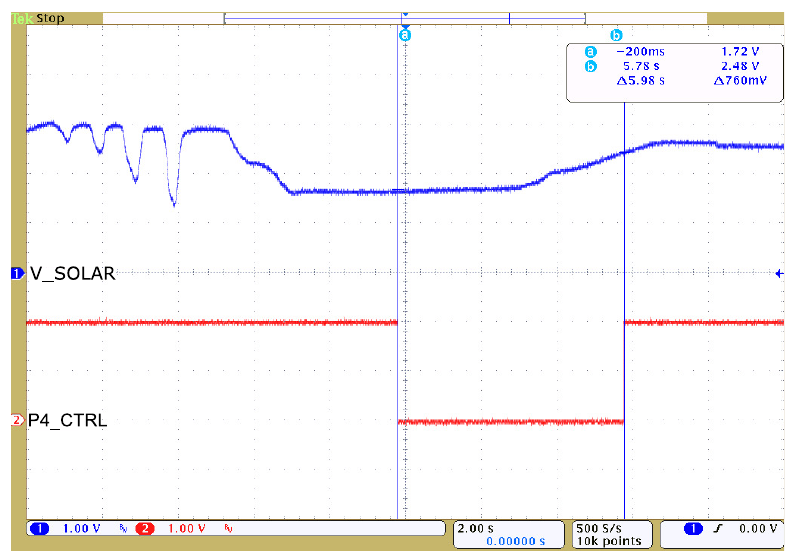
Figure 9. Day/night detector output signal dependence on the solar cell voltage. Waveforms are acquired at points denoted in Figure 1.